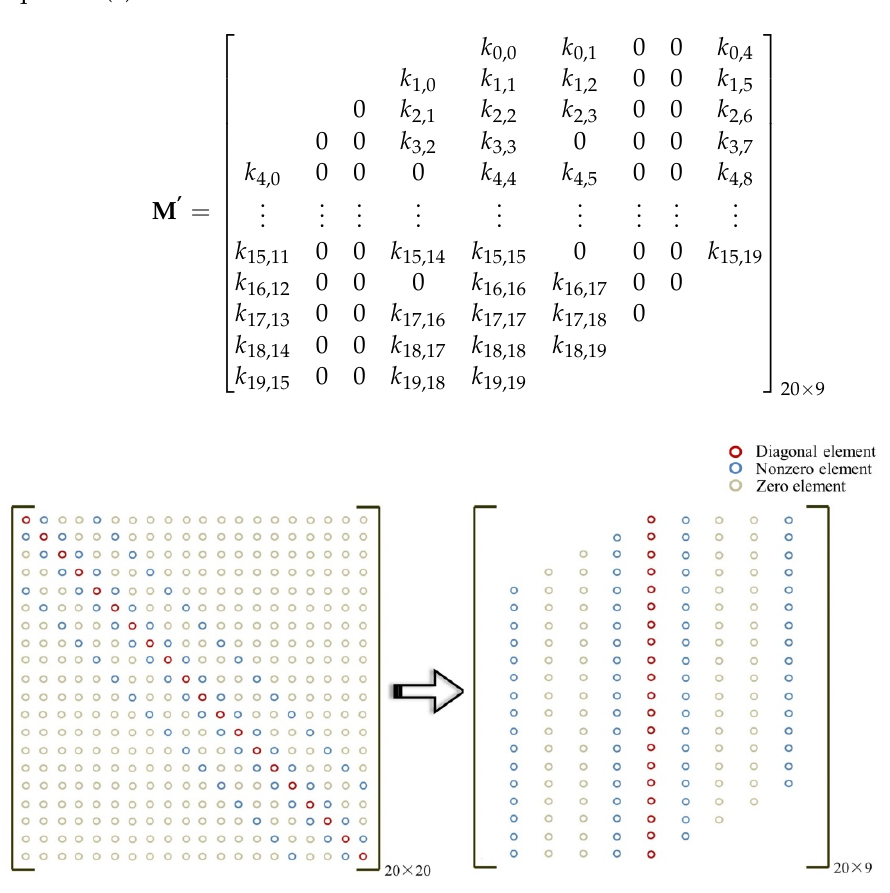
Figure 6. Compression process of the coefficient matrix M.